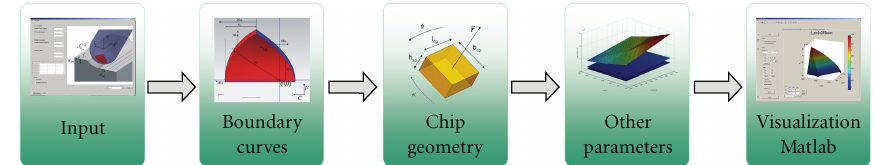
Figure 5: Simulation workflow.